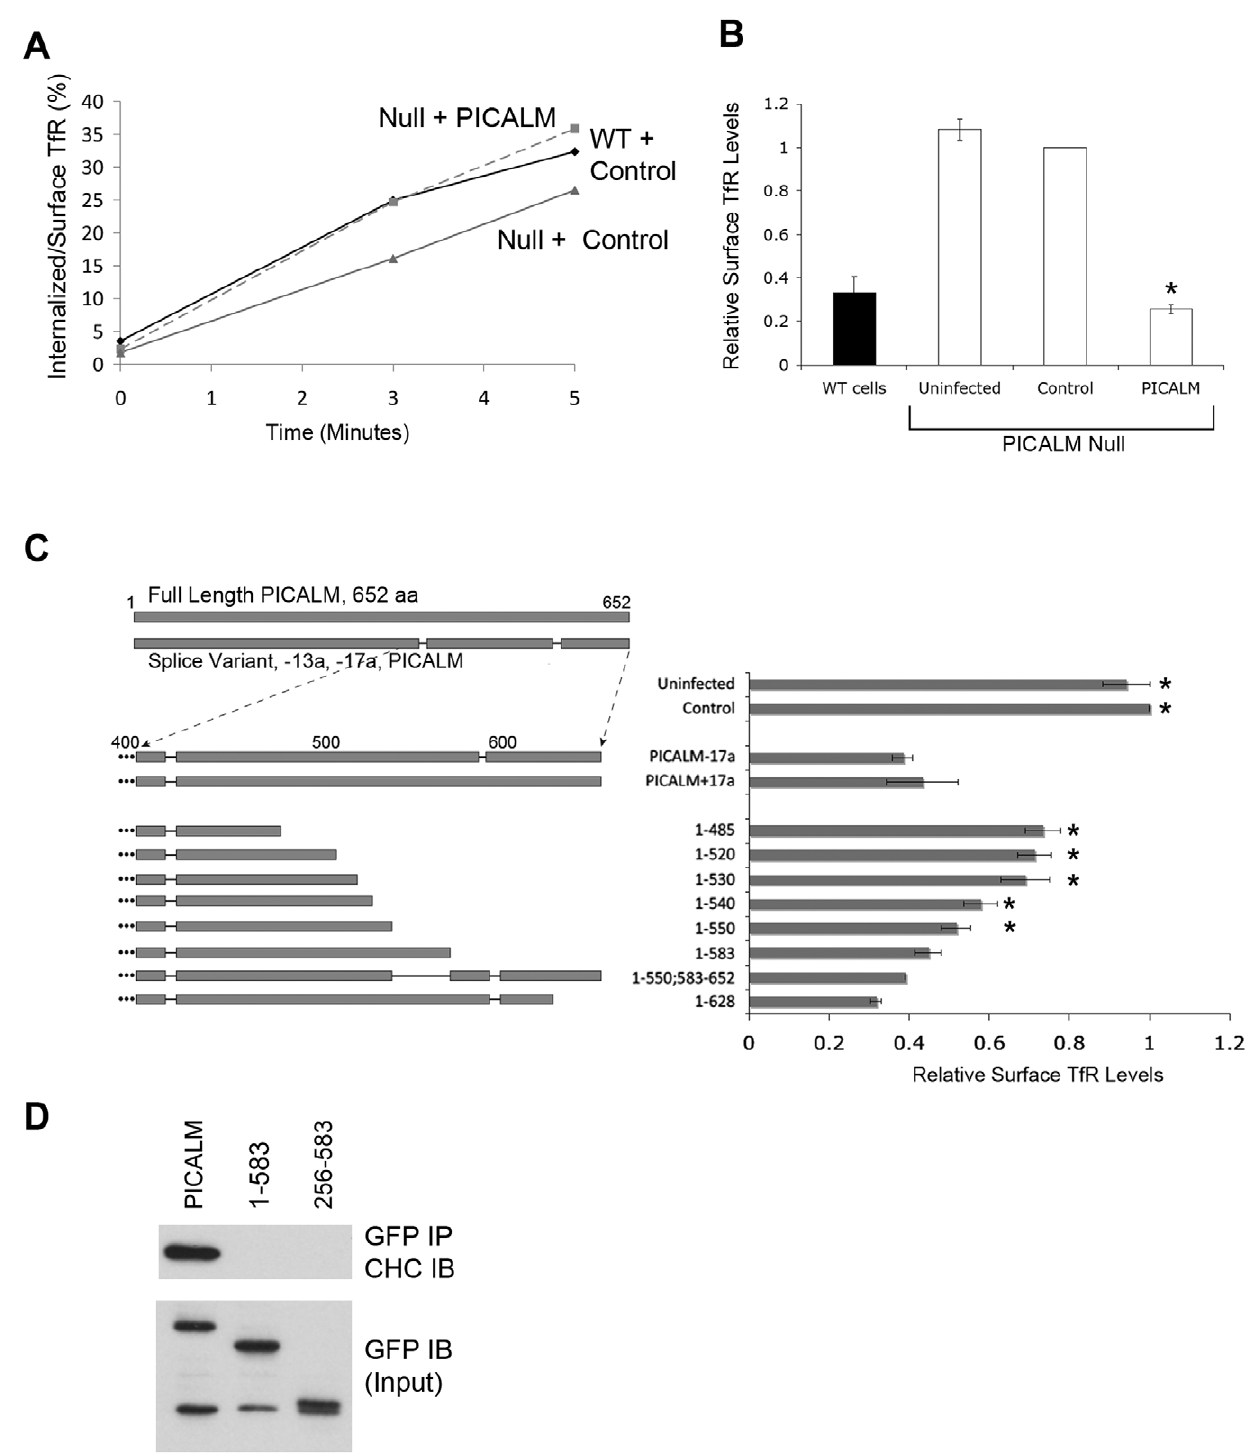
Figure 4. PICALM expression rescues the PICALM-deficient phenotype, and the PICALM carboxy-terminal domain plays an essential role. ( A ) Representative experiment showing rate of TfR internalization in Picalm NULL MEFs (line 31T) stably infected with PICALM or empty vector (control) compared with WT (line 33T) MEFs. ( B ) Surface TfR expression in WT MEFs (7T, 20T, 33T) or Picalm NULL MEFs (lines 3T, 24T, 29T, 31T) that were uninfected, stably infected with empty vector (control) or PICALM. Surface TfR levels were normalized to levels in control Picalm NULL MEFs. N exp =8. *p , 0.001 compared with control. TfR endocytosis and surface TfR levels measured in three independent Picalm NULL lines is shown in Figure S3. ( C ) Deletion mutagenesis of the PICALM carboxy-terminal domain (constructs depicted in left panel) demonstrates that the ability to rescue surface TfR expression is dependent on the PICALM carboxy-terminal domain. N exp =3. *p , 0.02 compared with PICALM-17a. ( D ) Co- immunoprecipitation of lysates from HEK293 cells transiently transfected with full length PICALM (PICALM: 1–652), carboxy-terminal truncated PICALM (PICALM: 1–583), or a PICALM mutant missing both the amino and carboxy-terminal regions (PICALM: 256–583). Extracts were